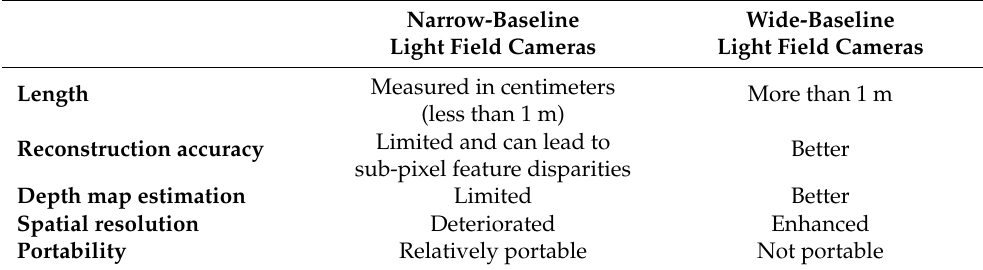
More than 1 m Better